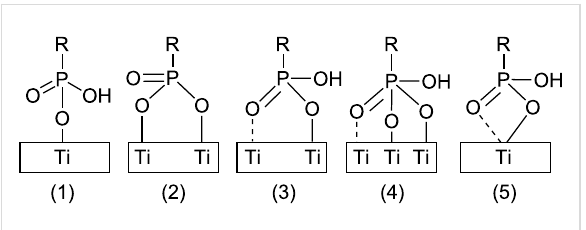
Figure 1: Schematic representation of binding modes between phos- phonic acid SAMs and titanium dioxide (1) monodentate, (2) and (3) bridging bidentate, (4) bridging tridentate, (5) chelating bidentate (adapted from